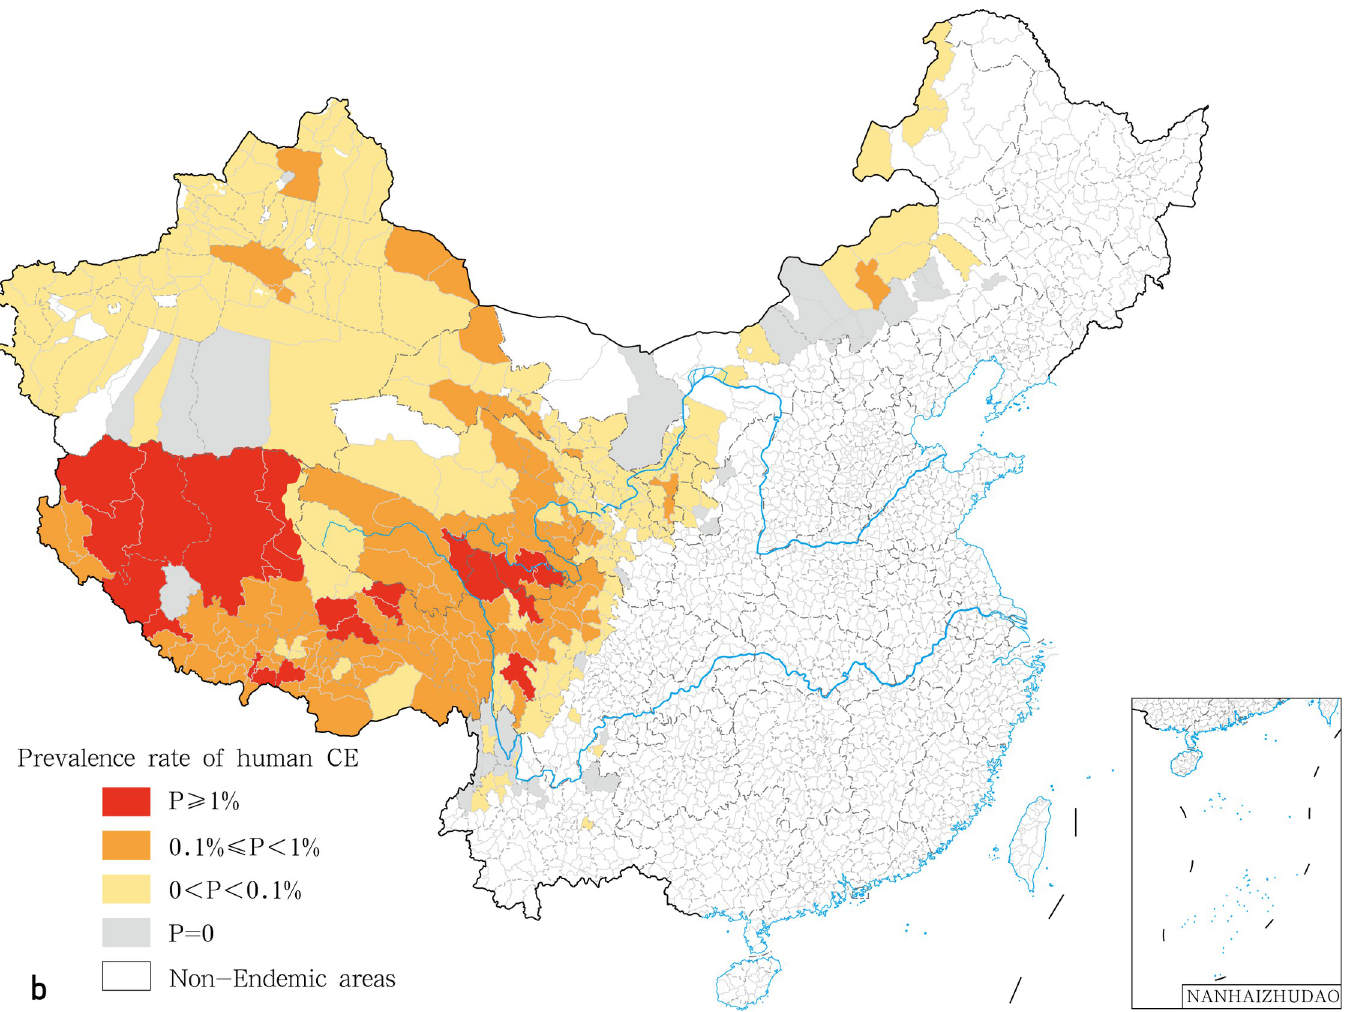
Fig 2. The spatial distribution of human CE in China in 2018. The base layer is from https://www.webmap.cn/mapDataAction.do?method=forw&resType=5&storeId=